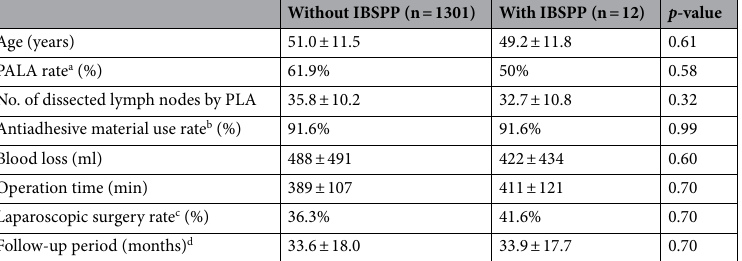
Without IBSPP (n = 1301) With IBSPP (n = 12) p -value